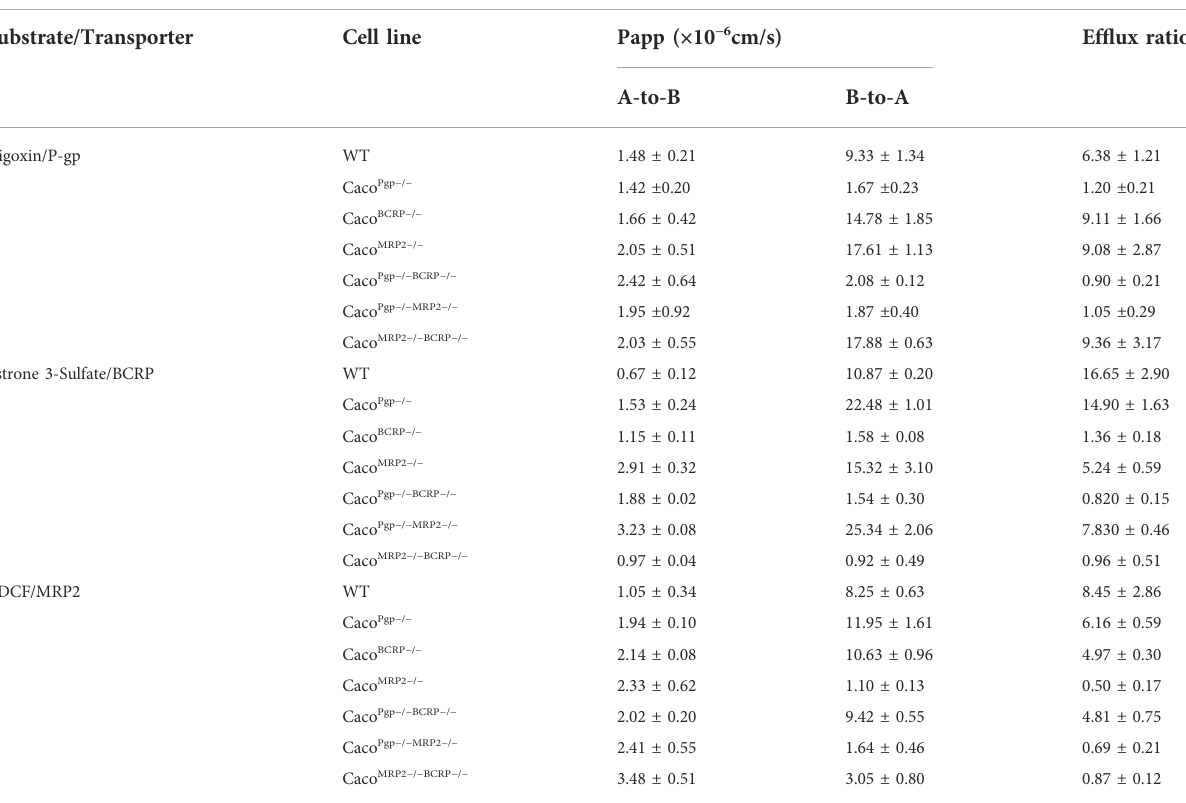
TABLE 1 Functional activity of ef fl ux transporters in KO